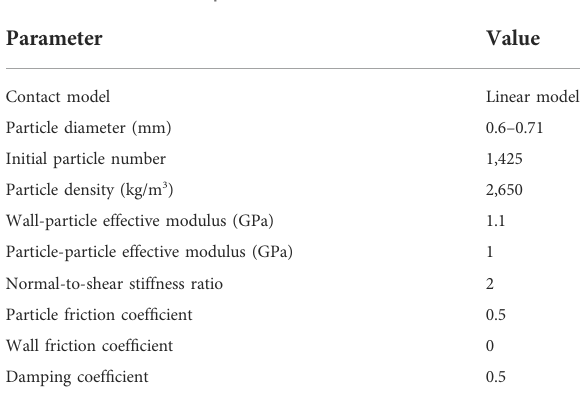
FIGURE 2 Simulation device and particle sample.